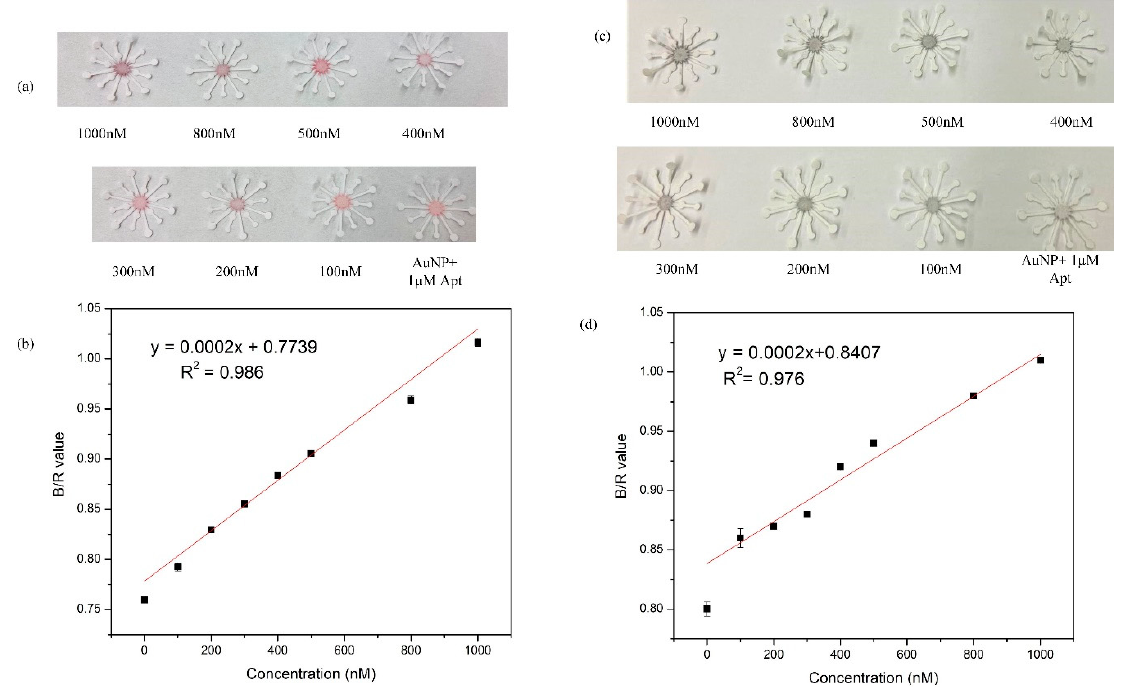
Figure 9. ( a ) Various concentrations of gentamicin samples in TE buffer (100–1000 nM) detected on paper substrate. ( b ) B/R values obtained using Image J plotted against various concentrations of gentamicin. ( c ) Milk samples spiked with known concentrations of gentamicin have been analyzed (100–1000 nM) on paper. ( d ) Corresponding B/R values (milk samples) vs concentration.